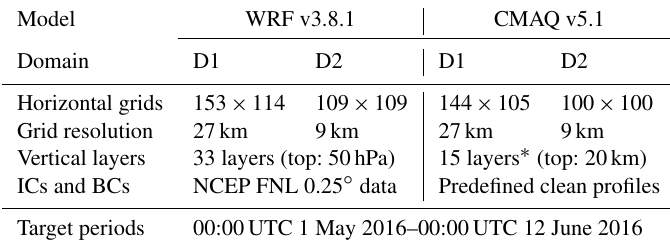
Table 3. Domain descriptions for WRF and CMAQ models.